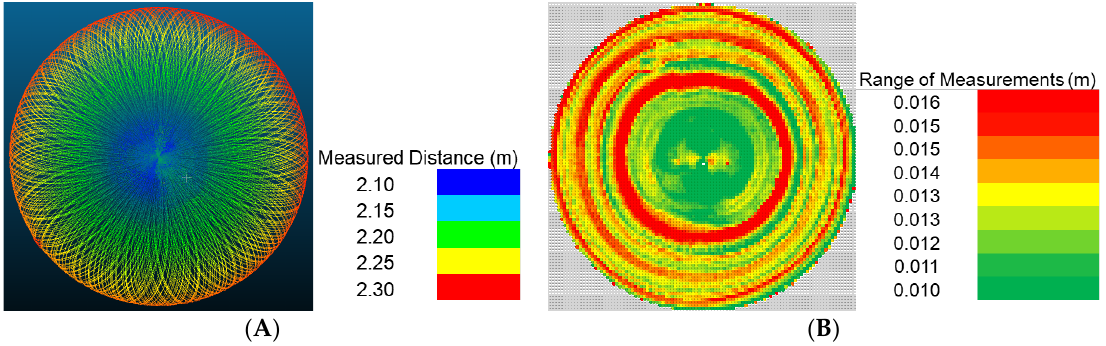
Figure 7. Breakdown of example Mid–40 data from ( A ) raw observations, colorized by measured distance, to ( B ) a 100 × 100 array of cells colorized by range of average distance measurements per cell.